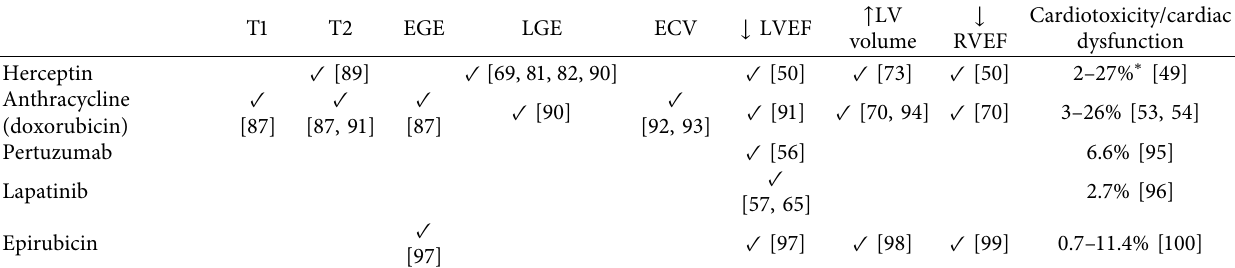
Table 5: CMR characteristics of chemotherapeutic agents.